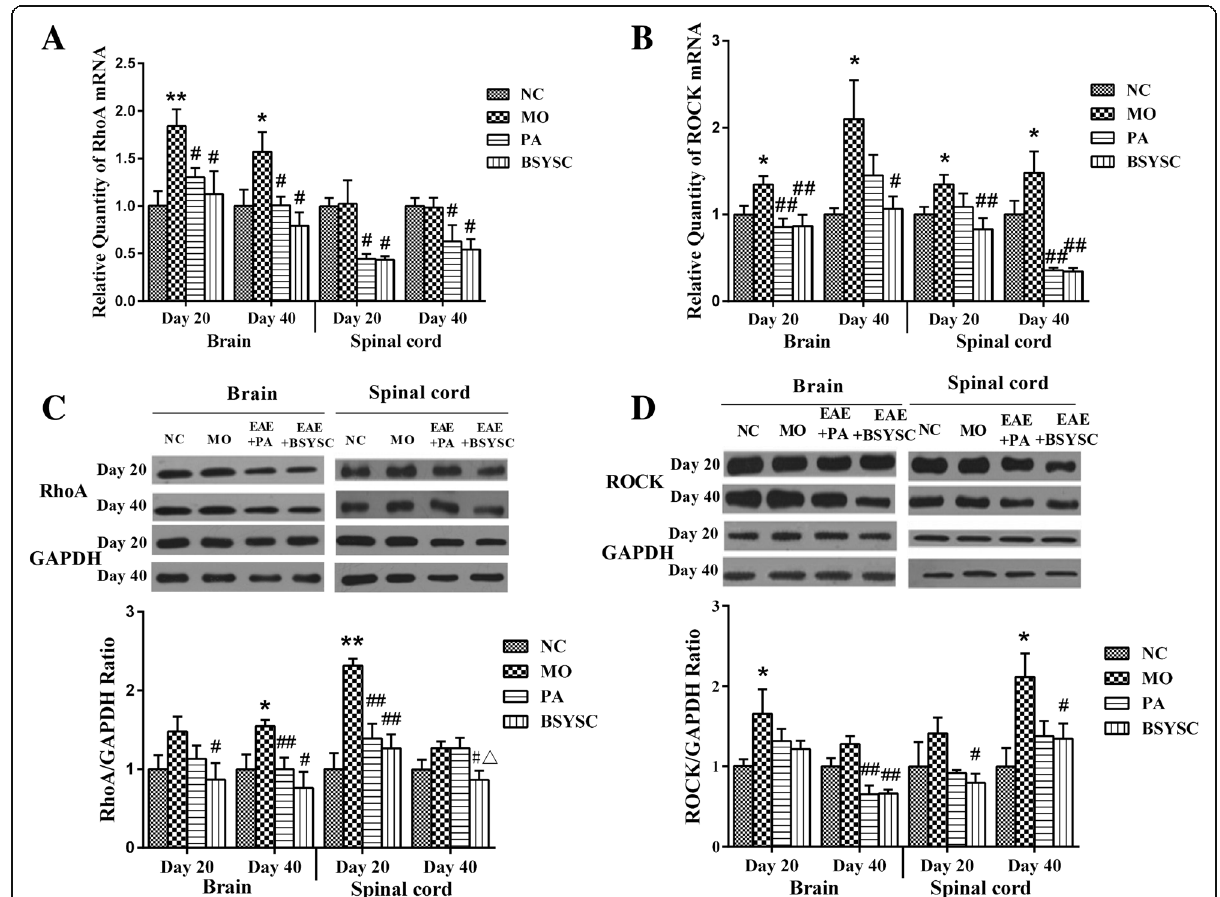
Fig. 7 Expressions of mRNA and protein of RhoA and ROCK in the brain and spinal cord of mice treated with or without BSYSC 20 and 40 dpi. RhoA and ROCK mRNA and protein levels were decreased to some extent by treatment of BSYSC. The mRNA levels of RhoA ( a ) and ROCK ( b ) were detected by qRT-PCR analyses. The protein levels of RhoA ( c ) and ROCK ( d ) were measured by Western blot and quantified using GAPDH as the loading controls. Data are expressed as means ± SE, n = 5 for each group. * p < 0.05, ** p < 0.01 vs. NC; # p < 0.05, 5, ## p < 0.01 vs. MO; △ p < 0.05 vs.